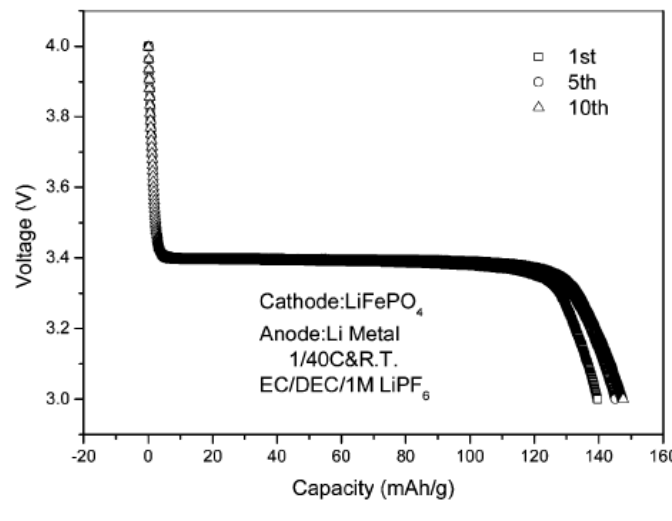
Figure 5. Discharge curves of LiFePO from [65]. Copyright 2004 Royal Society of